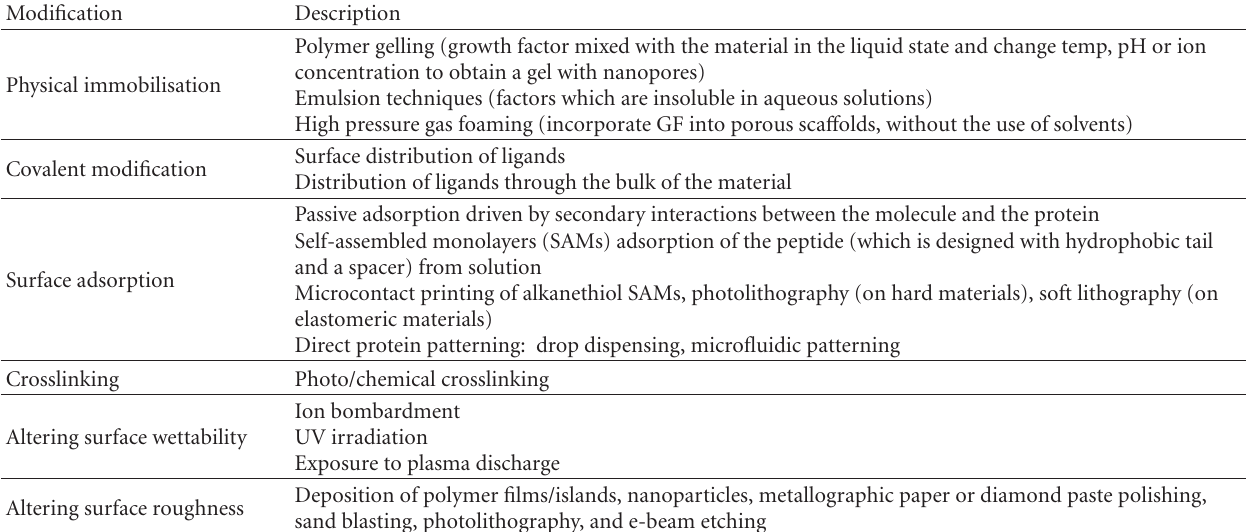
Table 1: Summary of the various modification techniques currently employed for optimising blood-material interactions [26].